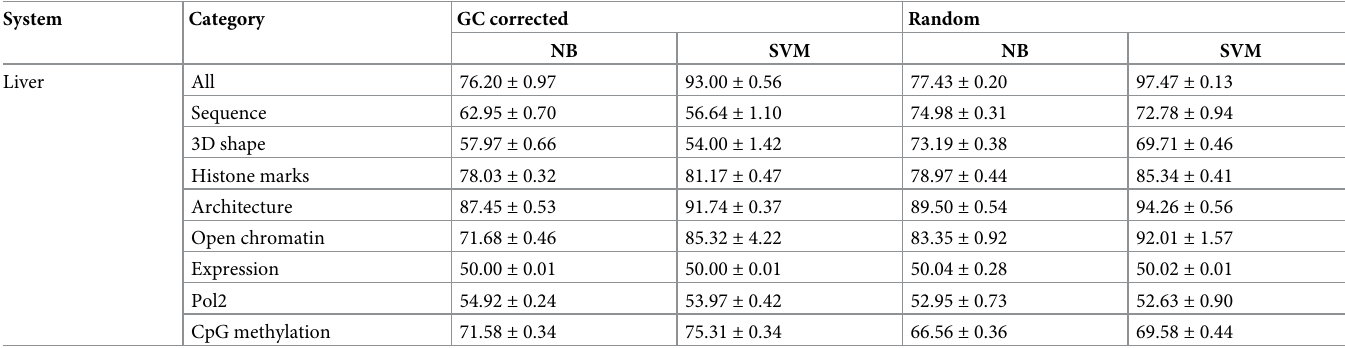
Table 2. Performance of SVM and NB classifiers in mouse